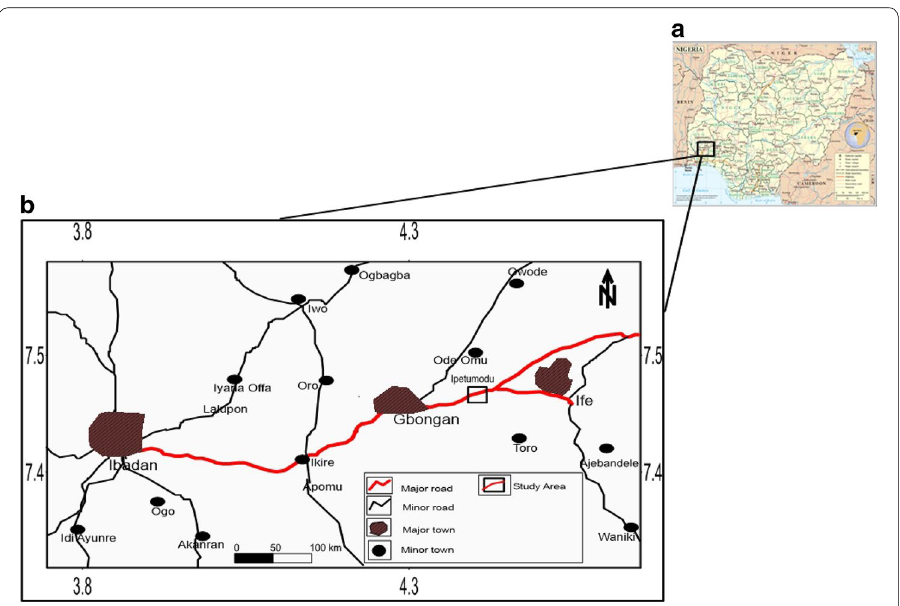
Fig. 1 a Road map of Nigeria (After [5]; b Road map of Ibadan-Ife Southwestern Nigeria (Adapted from Google map Inc,